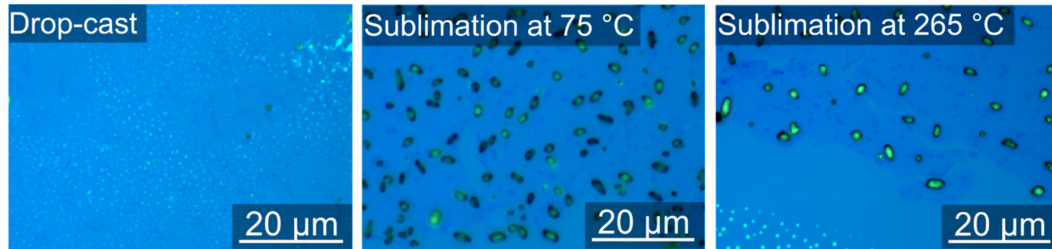
Figure 4. Images from the optical microscope of the samples after drop-casting and sublimations at 75 and 265 ◦ C.